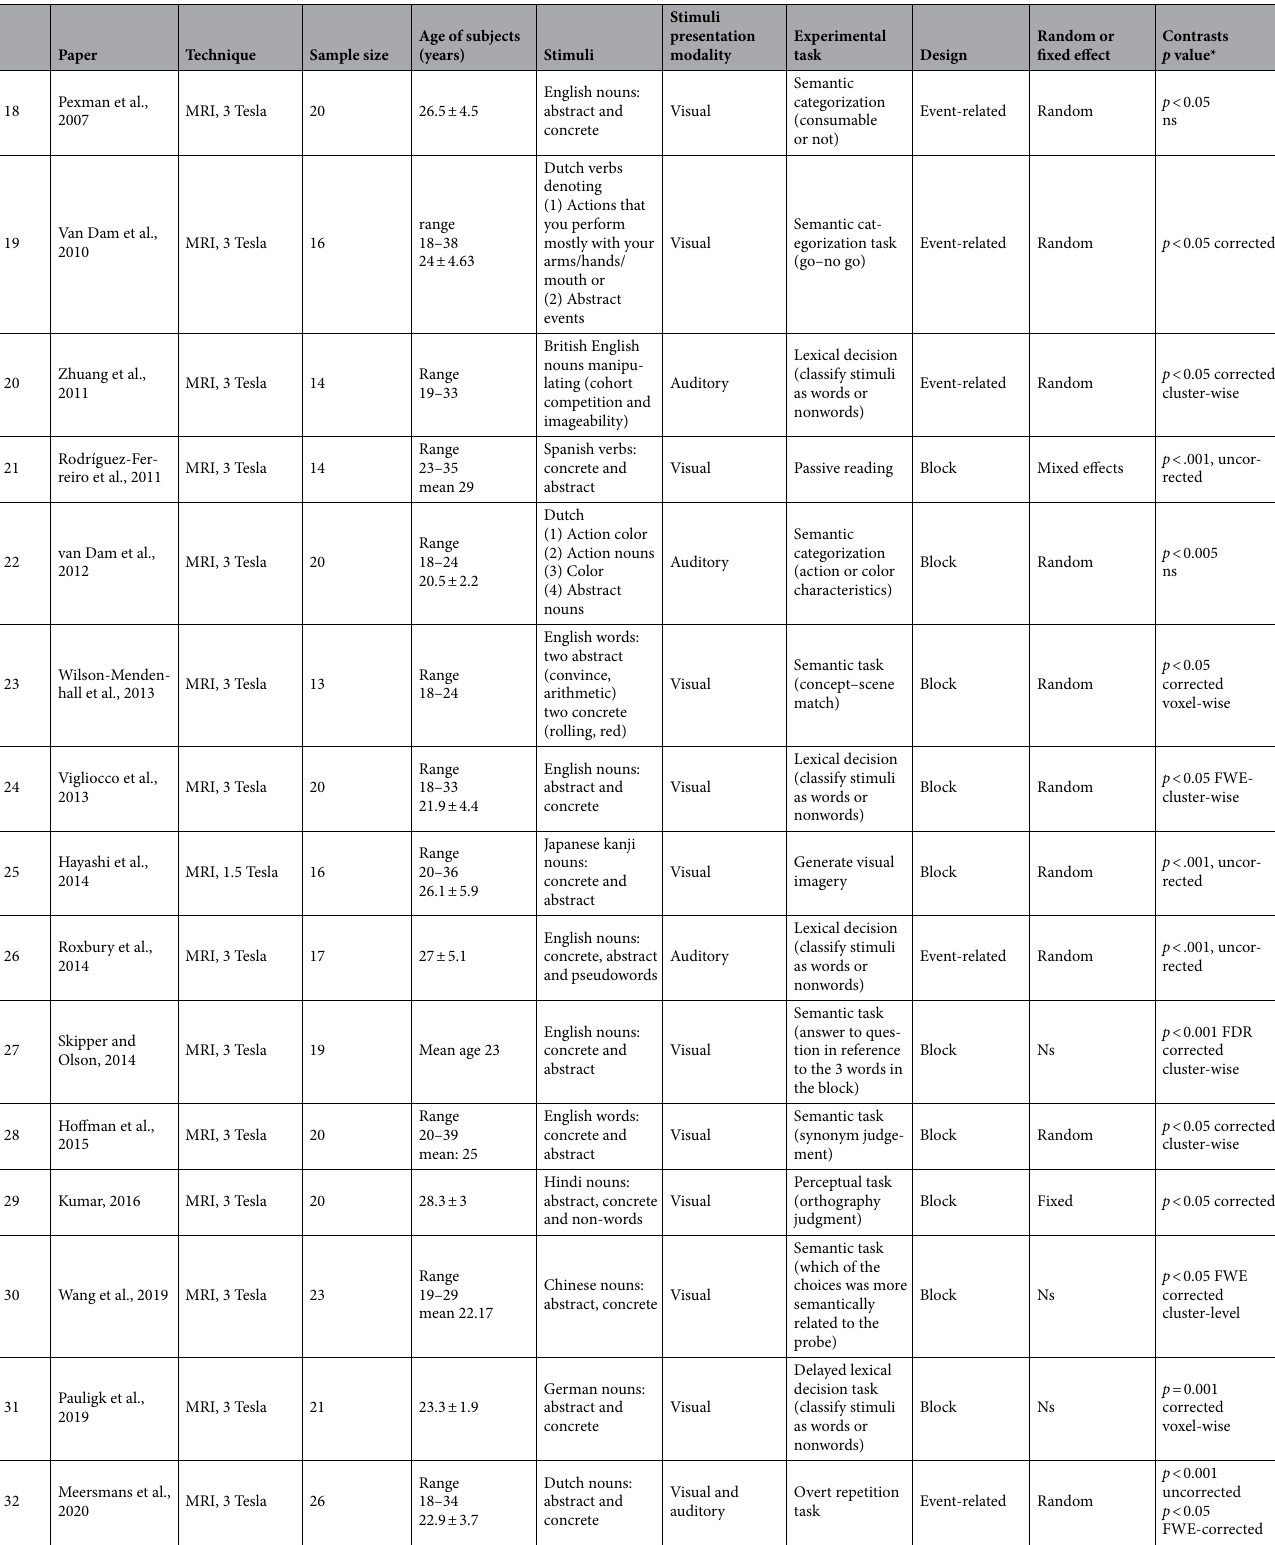
Table 1. Descriptive information of the 32 experiments included in the meta-analysis. Age is reported in years and when it was specified means and standard deviations are presented. p values (the statistical threshold for the neuroimaging univariate analysis conducted in the included papers) are reported as they were presented in the original articles; the exact value and the correction procedure was not always specified. ns, not